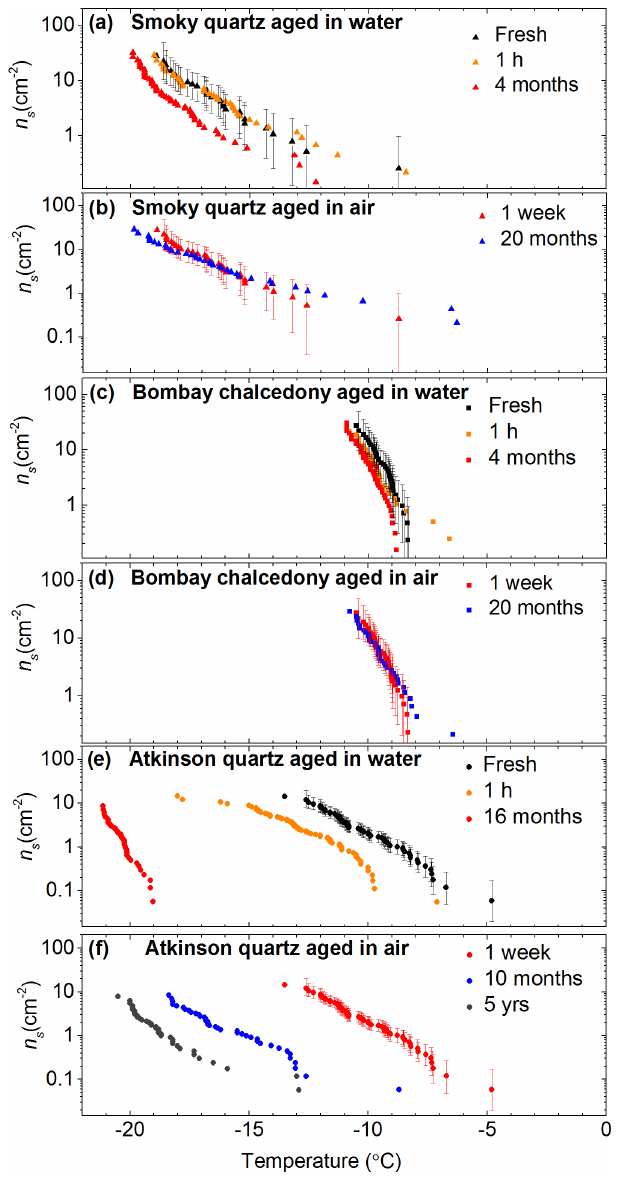
Figure 4. Plots showing the sensitivity of quartz activity, expressed as n s , to time spent in water and air. Data are shown for (a, b) Smoky quartz, (c, d) Bombay chalcedony and (e, f) Atkinson quartz. Error bars for the first run of each time series are shown but omitted for the other datasets for clarity. The n s values for the fresh ( ∼ 10min) and 1h suspensions were taken from Fig.